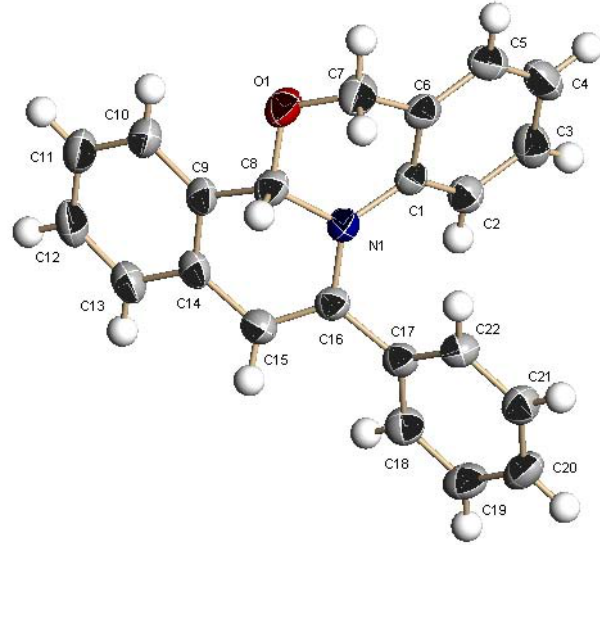
Figure 1. X-ray crystallographic structure of 3Aa